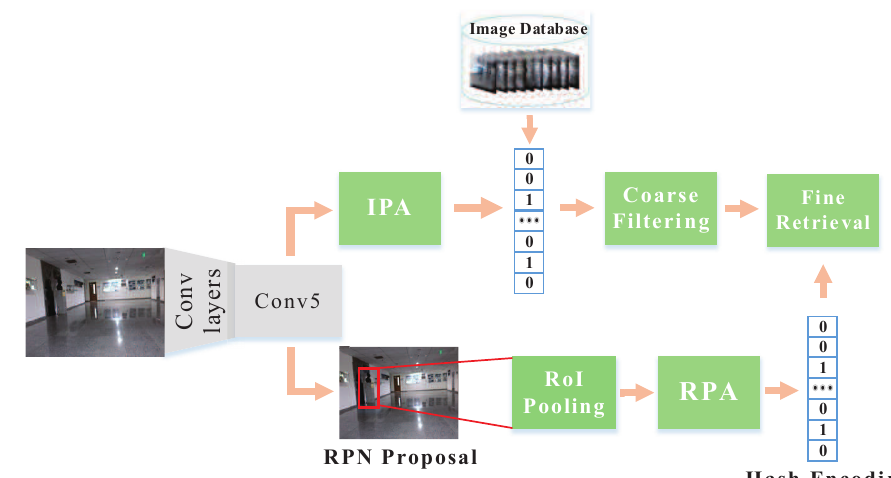
Figure 4. Architecture of the proposed image retrieval